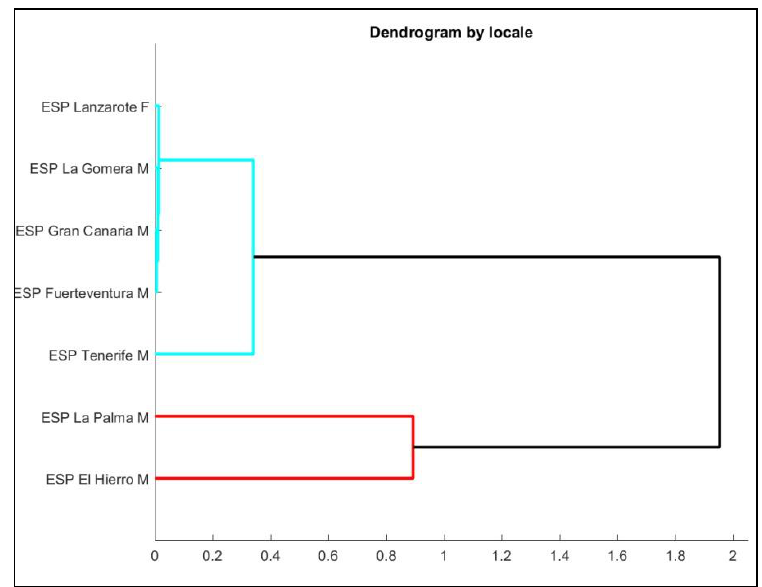
Figure 11. Dendrogram of SVO interrogative sentences by areas (vertical axis) and distance values along the horizontal axis.